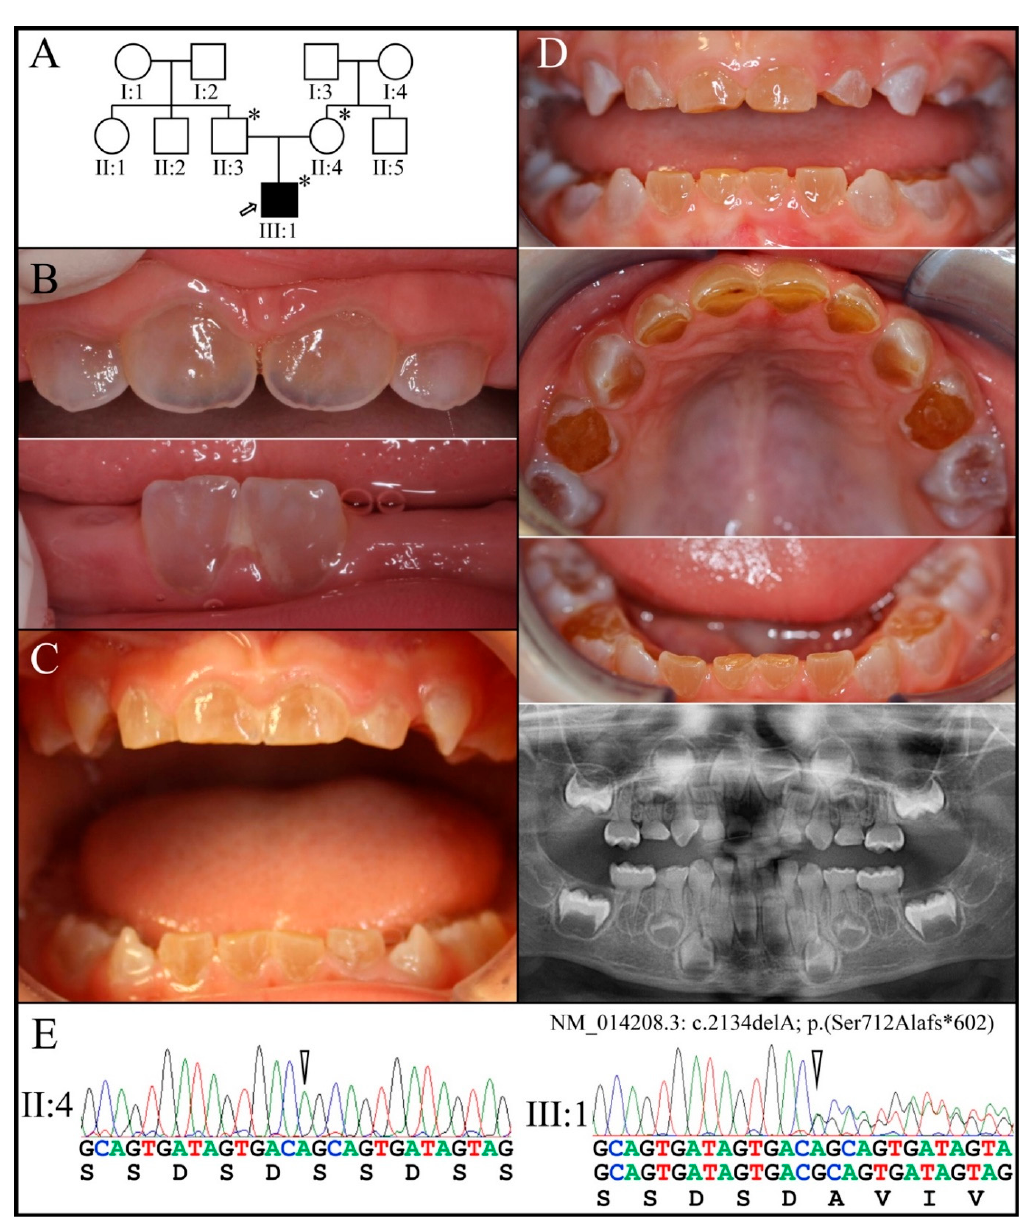
Figure 10. Family 7 ( A ): Three-generation pedigree of a family where only the proband (III:1) showed a dental phenotype. ( B ): The first erupted primary incisors of the proband (III:1) at age 11-months were opalescent with thin transparent enamel, and mild amber-brown discoloration. ( C ): The proband’s dental phenotype at 1-year 11-months showed amber-brown discoloration. ( D ): The proband’s dentition at age 3-years 4-months showed significant attrition, including com- plete shedding of the occlusal enamel from the four primary first molars. The panorex radiograph taken at this time showed bulbous molar crowns with obliterated pulp chambers and narrow, constricted roots. ( E ): Chromatograms showing the disease-causing heterozygous − 1 frameshift mutation in DSPP (c.2134delA; p.(Ser712Alafs*602). The proband’s father (II:3) also carried the disease allele. Key : * denotes enrolled